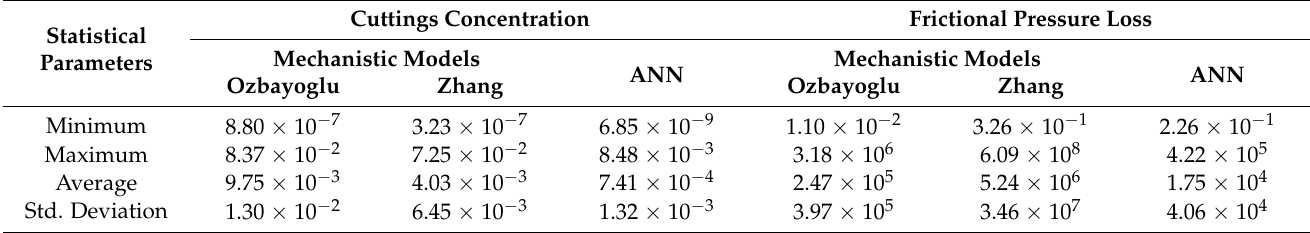
Table 2. A summary of the comparison of the squared error analysis between the mechanistic models and ANN.